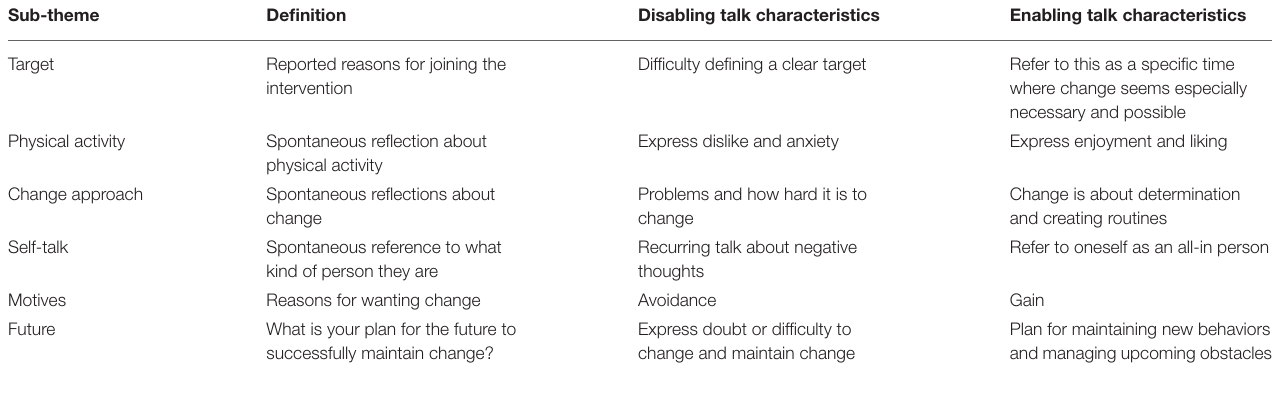
TABLE 5 | Defintions of sub-themes and their main themes